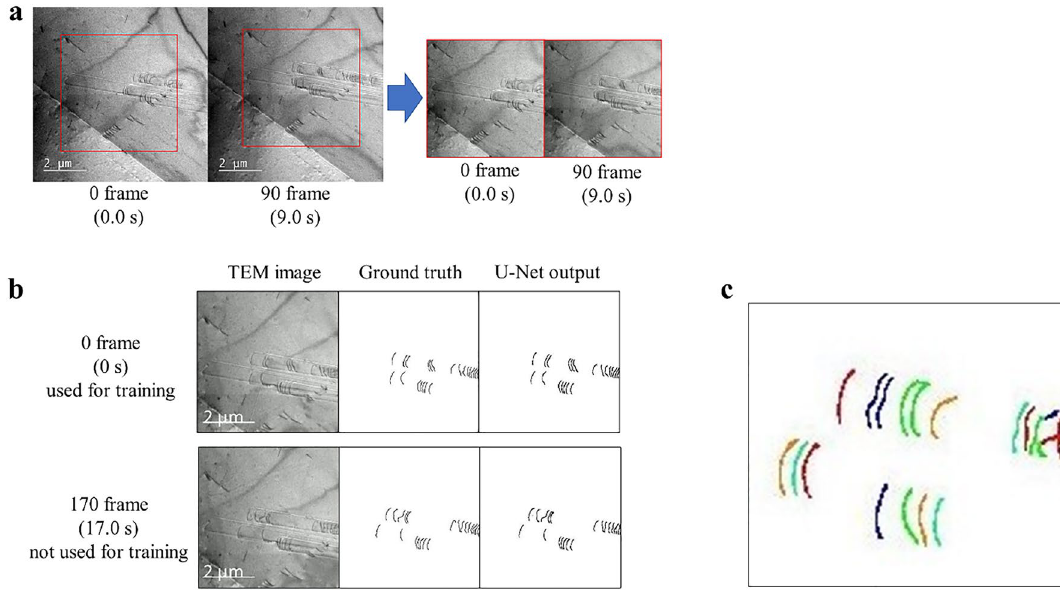
Figure 2. Selected frames from the in-situ TEM deformation experiment video demonstrating the image processing protocol. ( a ) Fixation of the FOV by optical flow: the unmatched coordinates of the FOV were in the left two images (before processing), were aligned by this process. For the following analysis, the FOV was kept consistent for the entire video by applying this process to all frames. ( b ) Binarization of dislocation and background by U-Net. U-Net outputs the same image as ground truth for frames not used for training. ( c ) Identification of each dislocation by image processing shown in Fig. 7. The dislocations were classified